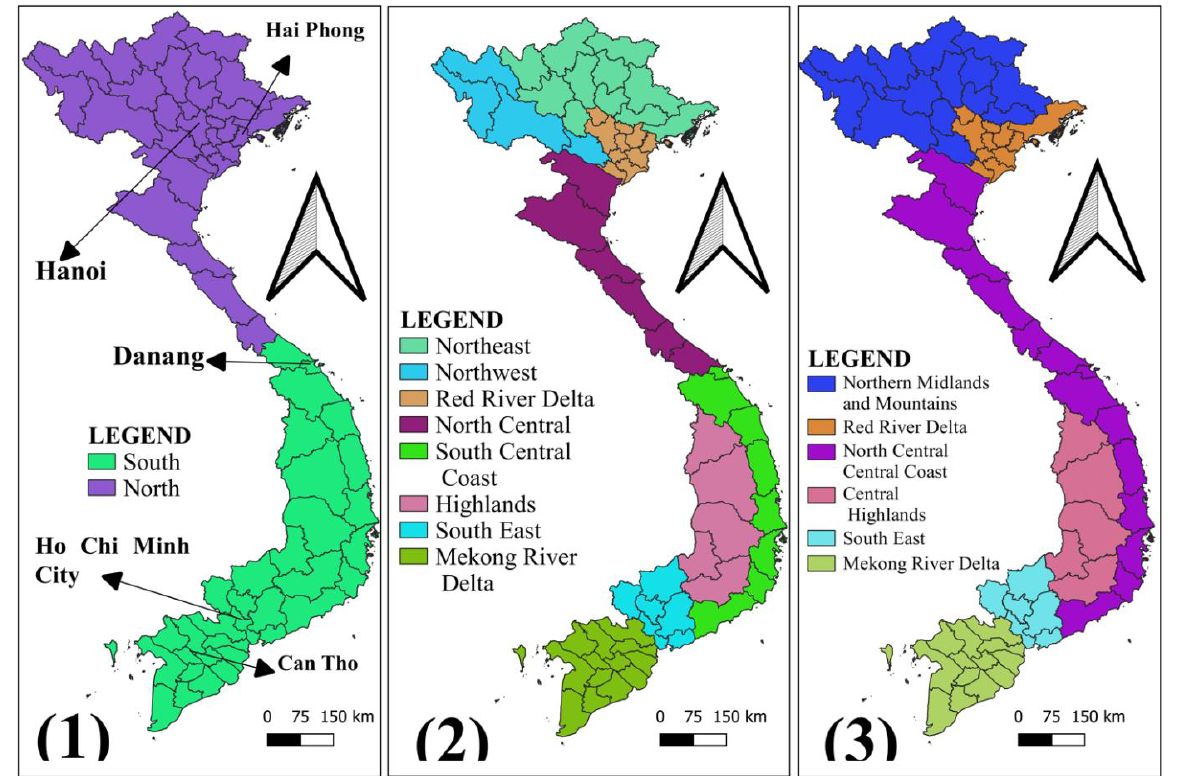
Fig. 1. Land use zoning in Vietnam (Source: author’s compilation): (1) – from 1954 to 1975; (2) – before land law of 2013; (3) –